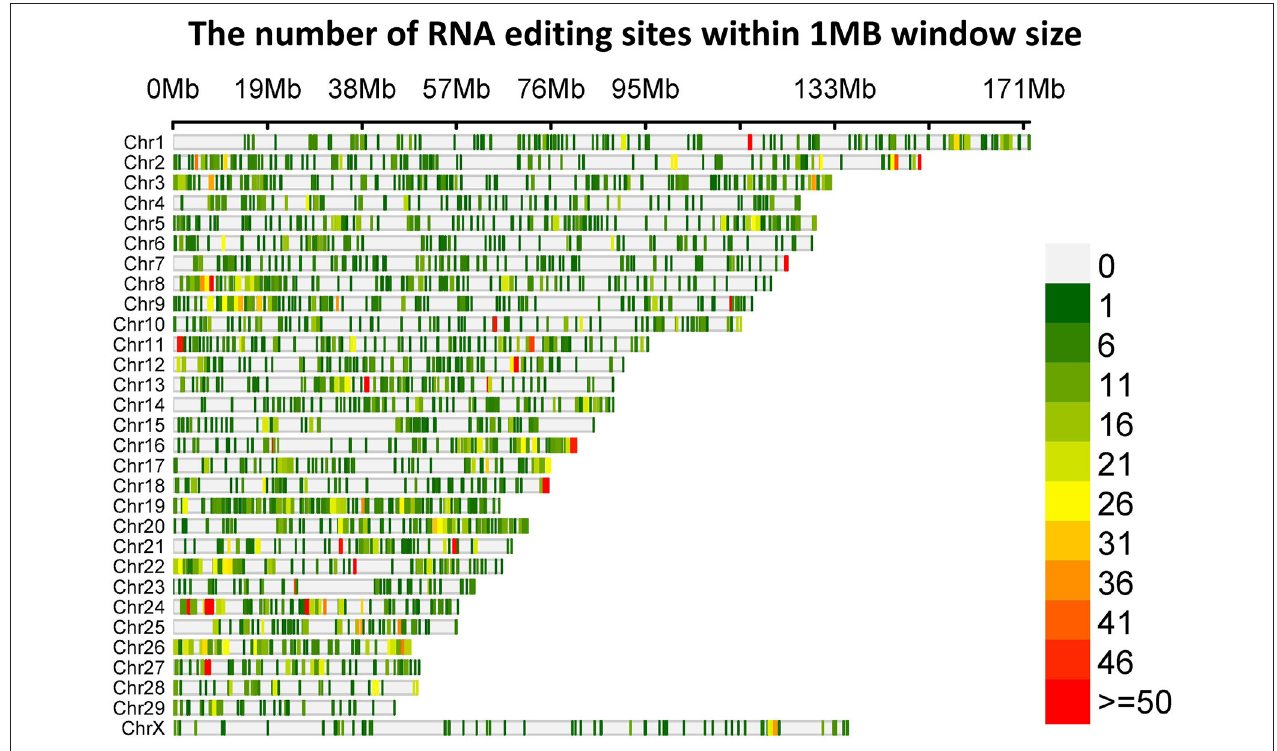
FIGURE 1 | The distribution of RNA editing sites throughout the yak genomes.